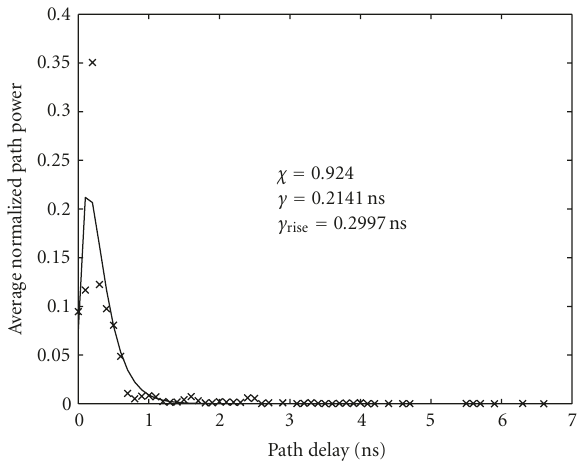
Figure 21: Normalized path power decay for measurements from the Taurus engine compartment.